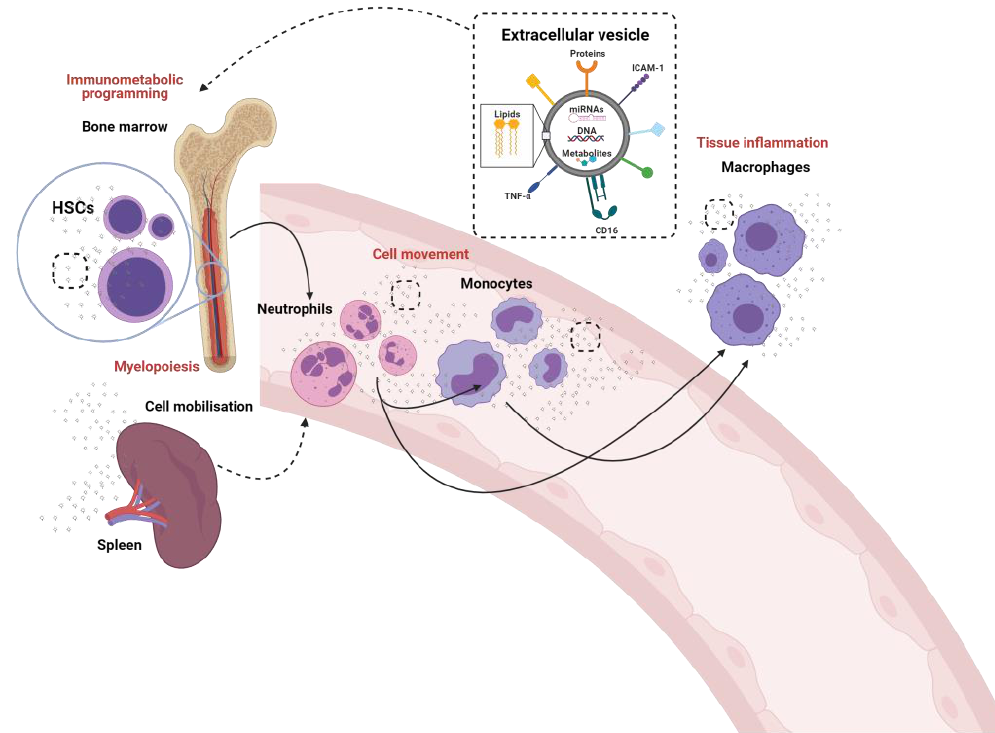
Figure 1. The crosstalk between innate immune cells through the generation and release of extracellular vesicles. The known (solid lines) and proposed (dotted lines) role of extracellular vesicles in the modulation of neutrophils, monocytes and macrophages and their pre-cursor hematopoietic stem cells (HSCs).